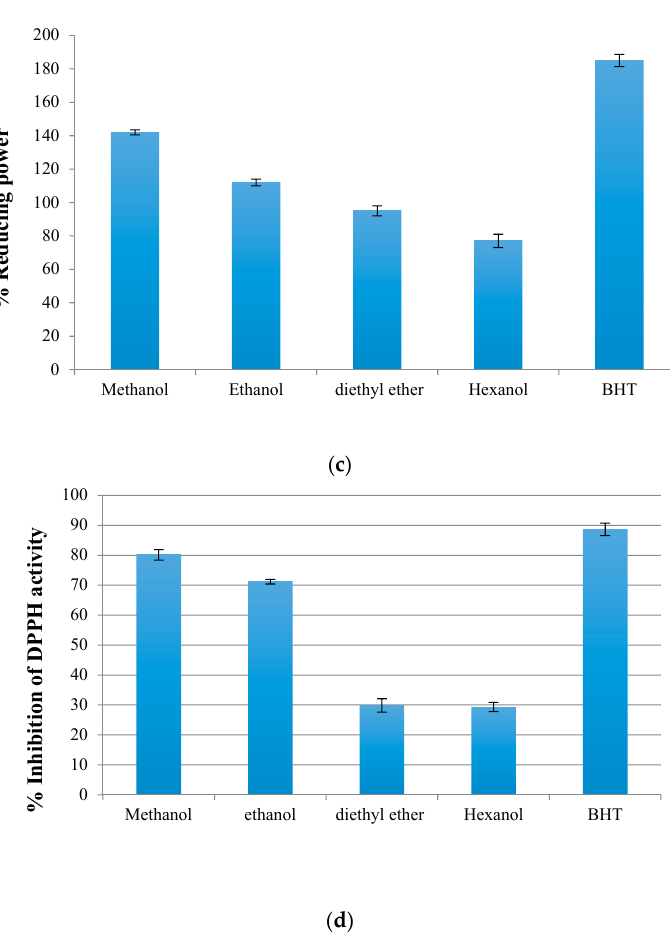
Figure 1. ( a ) Total phenolic content of the olive leaf. ( b ) Percentage of inhibition of linoleic acid peroxidation. ( c ) Percentage of reducing power of the olive leaf extracts. ( d ) DPPH radical scavenging activity of different plant extracts.